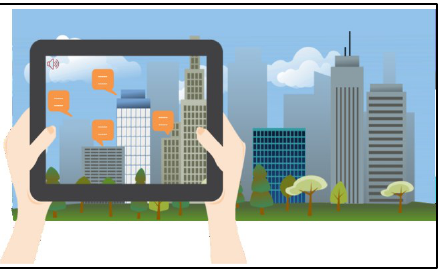
Fig. 1. Example of augmented reality application